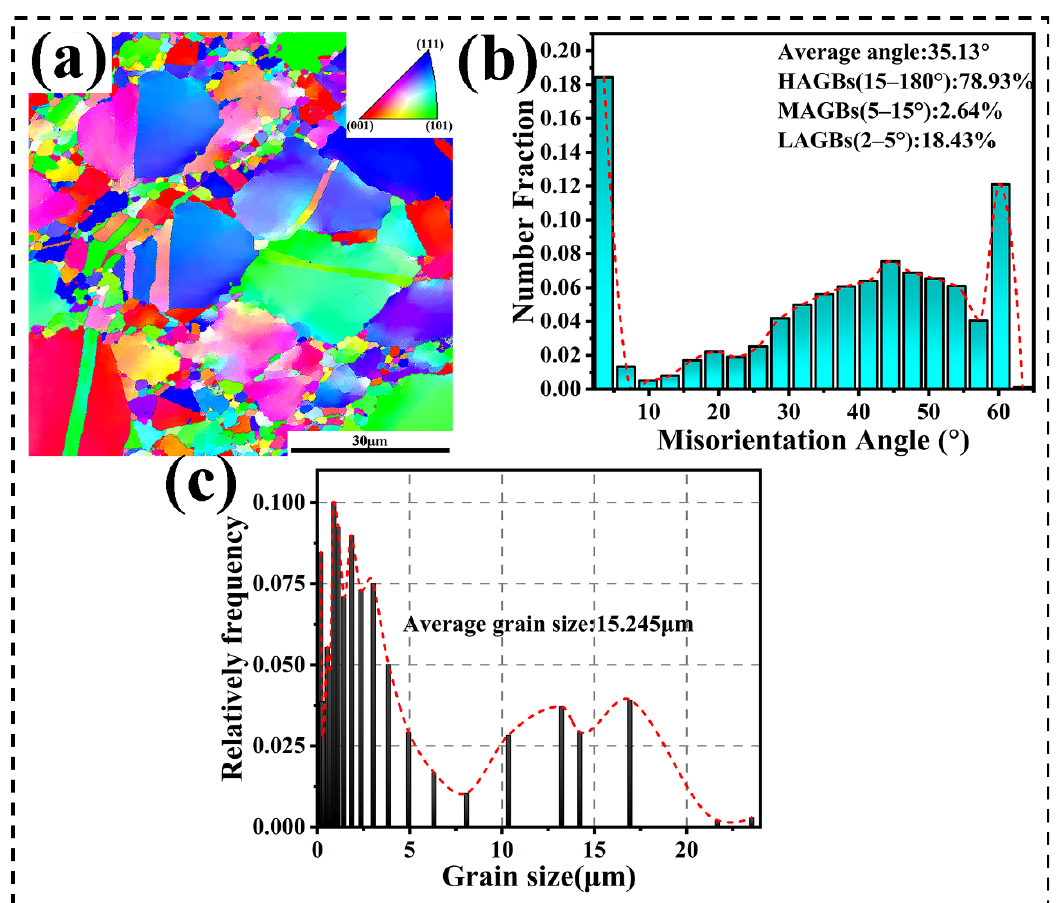
Figure 3. The initial microstructure of studied superalloy before hot deformation: ( a ) orientation image microscope map, ( b ) distribution of misorientation angles, ( c ) distribution of grain size.